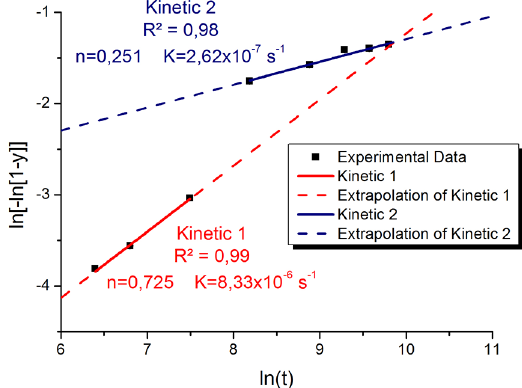
Figure 6. Linear fits of the experimental sigma phase volumetric fraction data obtained for each time of isothermal heat treatment at 850